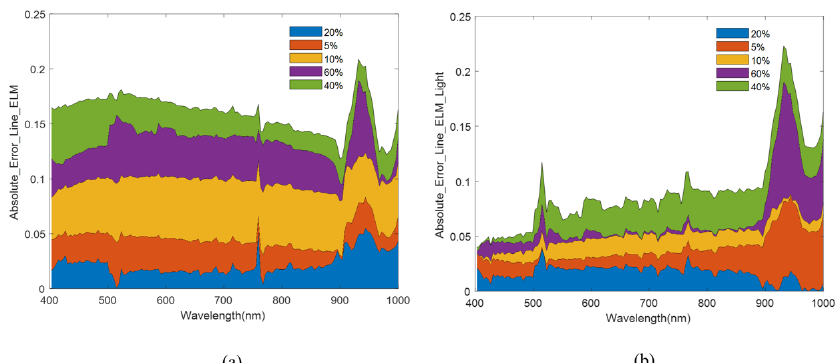
Figure 11. The absolute error between the retrieved results of multi-gray level calibration target and in suit measurement results: ( a ) ELM method; and ( b ) ELM method of adding illumination correction.